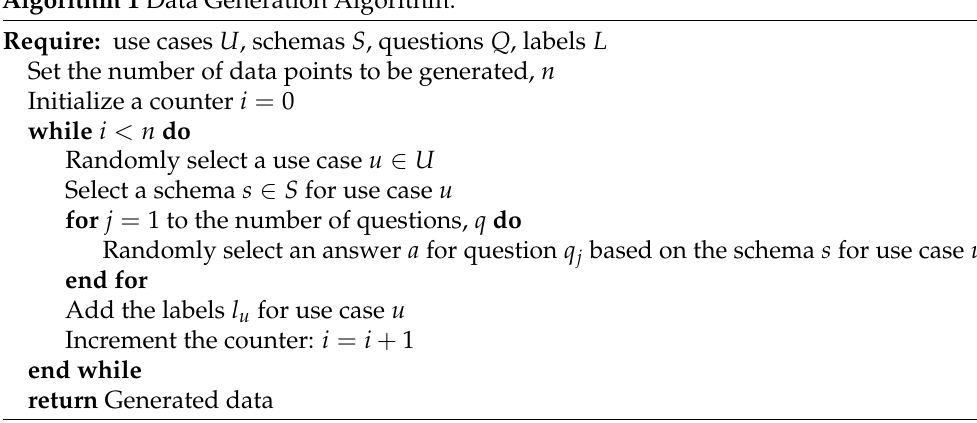
Algorithm 1 Data Generation